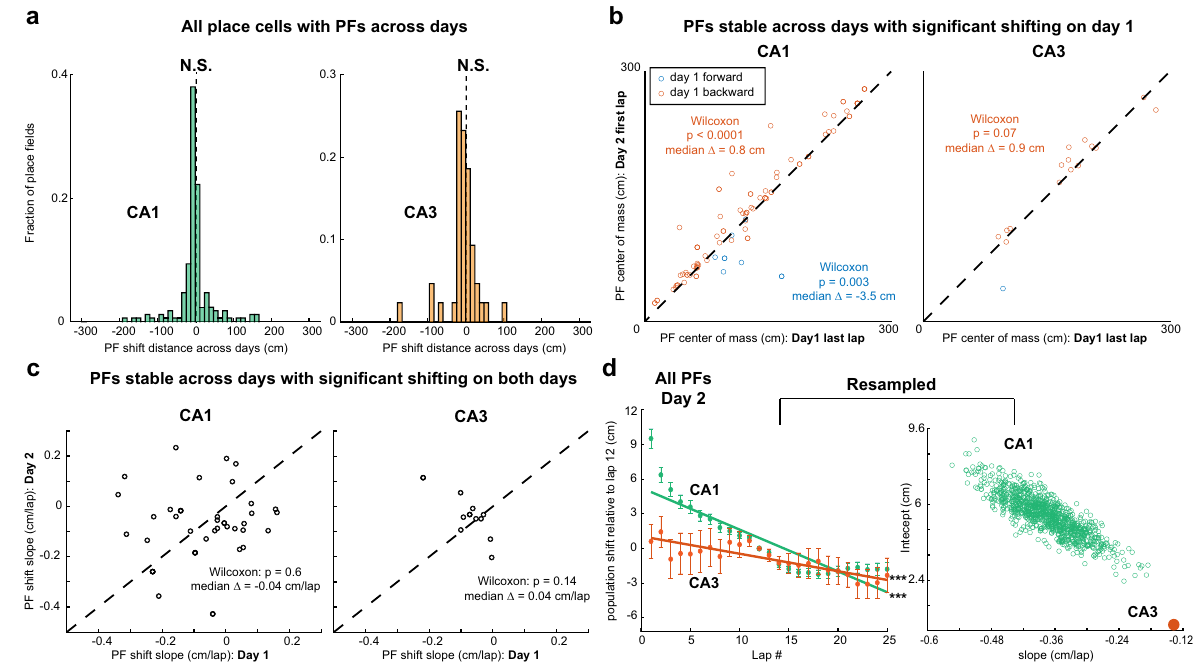
Fig. 5 Place fi eld shifting resets and continues upon fi rst re-exposure to N on day 2. a Histogram of place fi eld (PF) shifts across days for CA1 (left, n = 171 PFs) and CA3 (right, n = 43 PFs). The shifts were calculated as the difference between each PF ’ s center of mass (COM) on the last active lap on day 1 and fi rst active lap in day 2. Only place cells with PFs on both days are included. Wilcoxon signed-rank test, two-sided. N.S., P > 0.05. b Comparison of COM position at the end of day 1 and COM position at the start of day 2 for PFs with day-to-day correlation >0.5 and signi fi cant shifting on day 1 (see Fig. 3c). Dashed diagonal: identity line. On day 2, PFs tend to reset towards the direction opposite of shifting on day 1. Two-sided Wilcoxon sign-rank test on Day 2-Day 1 difference from 0 for backward and forward shifting ( P values and median in panel). c Comparison of PF shifting slope on both days. No clear correlation is observed, but the Day 2-Day 1 difference is not signi fi cantly different from 0 (Wilcoxon sign-rank, two-sided: P values and medians in panel) and individual PF shifting was slow (close to 0 cm/lap) on both days. d Population shift of PF COM. Left, mean ±SEM, over all PFs, of fi ve-lap sliding average COM difference relative to lap 12 (see Methods), in N day 2. CA1 (green; n = 371 PFs from three mice) and CA3 (orange; n = 84 PFs from six mice). Linear regression, F test, *** P < 0.001 CA1, P < 1 × 10 − 100 , CA3, P = 1.1 × 10 − 4 . The resampling analysis (1000 random resamples matching the CA3 sample size) shows that CA1 slopes are always steeper than the CA3 slope, indicating that on day 2 the CA1 population shifts backward faster than